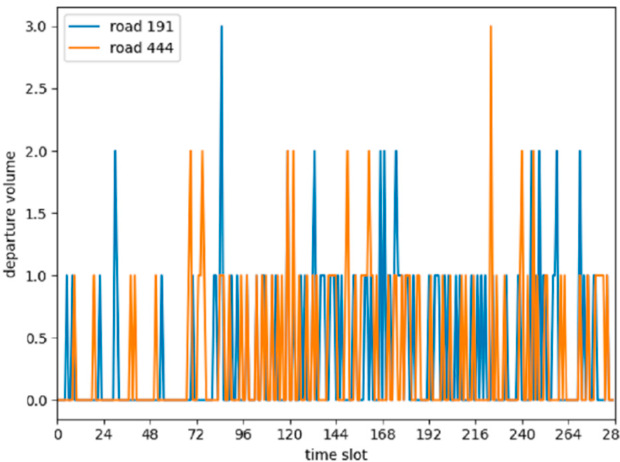
Figure 1. Similar traffic flow patterns on road 191 and road 444.